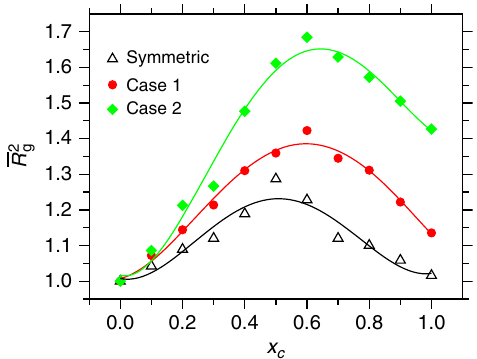
Fig. 1 Polymer conformation and the effect of different mixtures of poor solvent conditions. Normalized squared radius of gyration R 2 R 2 as a function of cosolvent molar concentration x Results are shown for the generic simulations and for three different cases. The parameter-speci fi c details of the generic cases are listed in the Supplementary Table 1. The results are shown for a chain length of N l = 30, which corresponds to (cid:1) 30 ‘ p with ‘ p being the persistence length. Here R Þ is the normalized Θ — point gyration radius. Here case 2 closely mimics the conformational behavior of PMMA in aqueous methanol mixture based on the parameterization presented in the Supplementary Table 1. Lines are polynomial fi ts to the data that are drawn to guide the